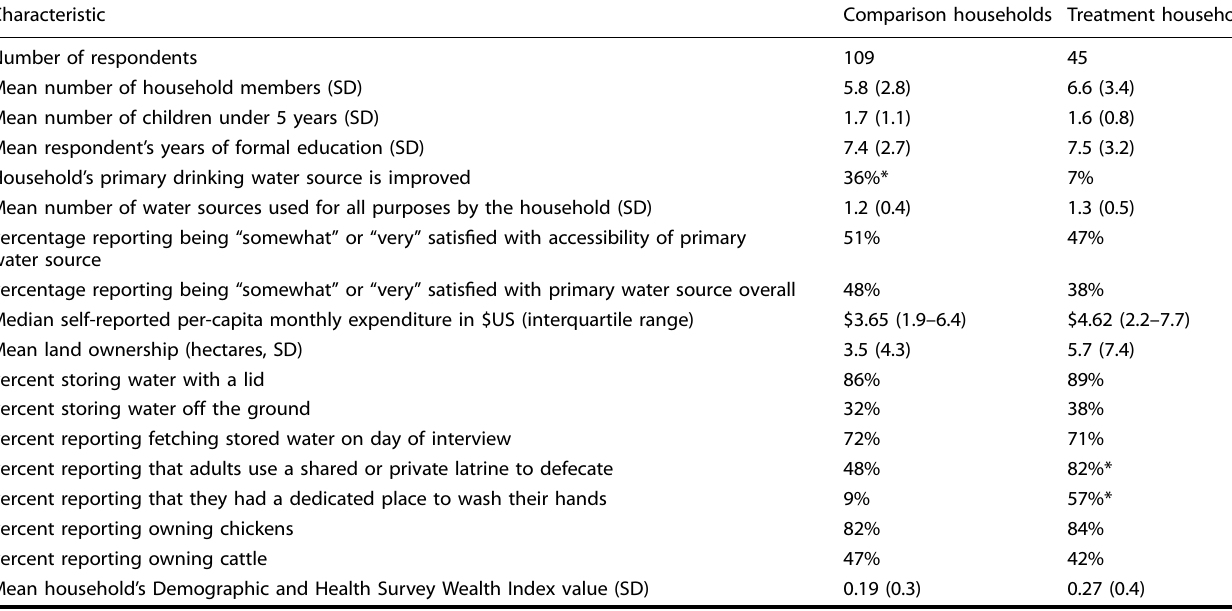
Table 1. Baseline socioeconomic and WASH characteristics of respondents, by study group.